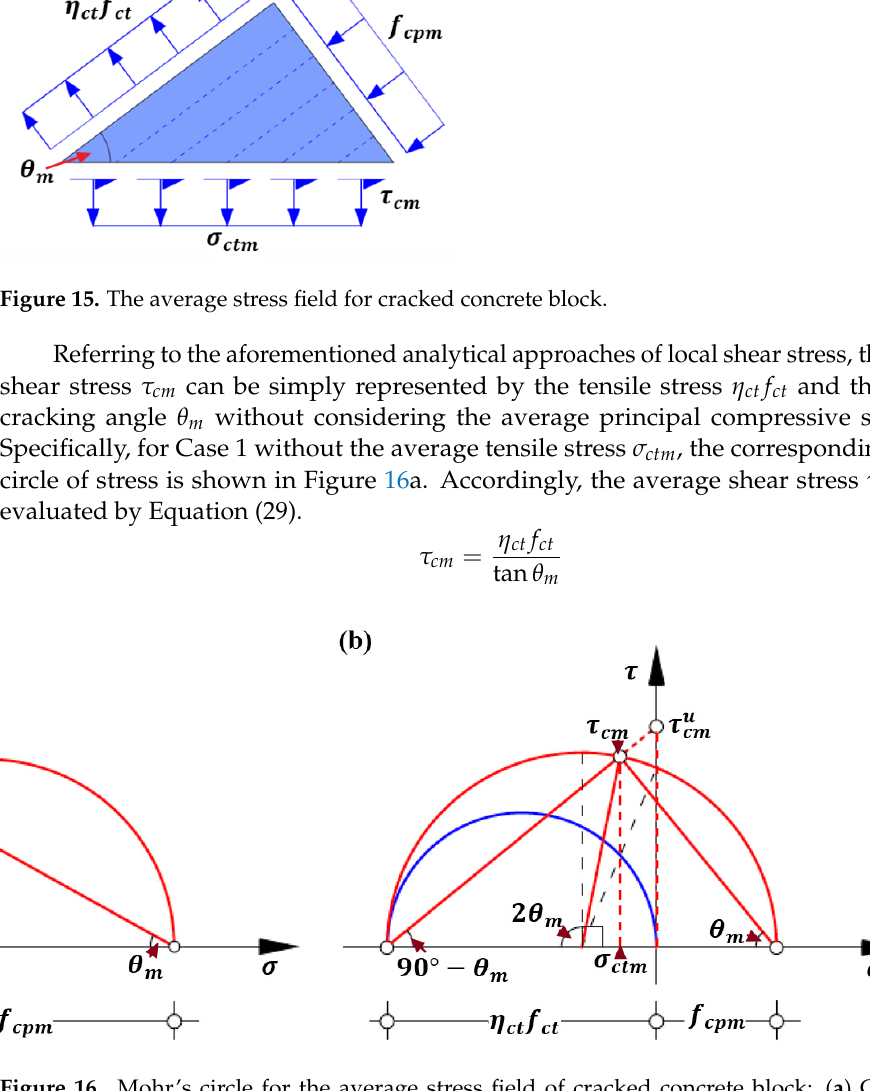
Figure 16. Mohr’s circle for the average stress field of cracked concrete block: ( a ) Case 1; and ( b ) Case 2.